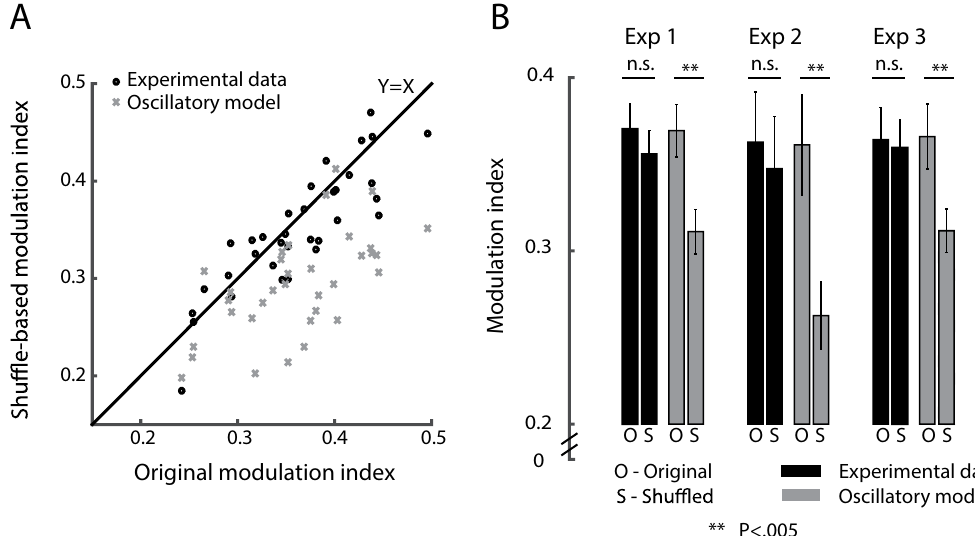
Figure 7. Modulation indices of individual subjects and groups. ( A ) For each subject, the shuffled sequence modulation index is plotted as a function of experimental modulation index (black circles). As a baseline for this analysis, the shuffled simulated oscillatory sequence modulation index is plotted as a function of the original modulation index (gray Xs). ( B ) For each experiment, the mean modulation index before and after shuffling is given, both for experimental data (black) and oscillatory model (Gray). Data are represented as mean ± SEM, N = 12,11,12 for Exp 1–3